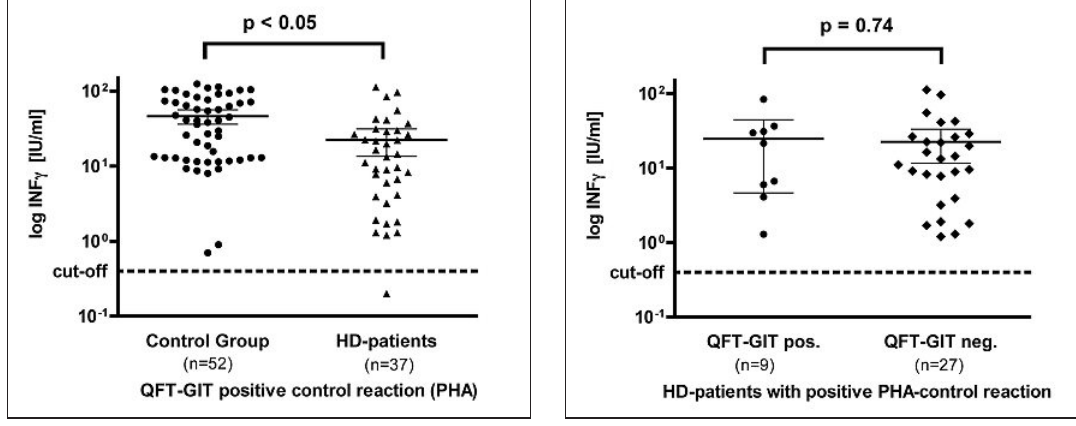
Figure 2 A & B Comparison of INF- g secretion upon mitogenic stimulation (A) in healthy controls (n = 52) vs HD-patients (n = 37), and (B) comparison within the HD-group in non-anergic patients who tested QFT-GIT negative (n = 26) or QFT-GIT positive (n = 10).The median INF- g titre in the control group versus the HD-patient group was 46.2 IU/ml versus 22.4 IU/ml (p <0.05). The median INF- g secretion of the control reaction in HD-patients tested QFT-GIT positive or negative was 24.6 and 22.5 IU/ml, respectively (p = 0.57). INF- g = interferon g ; PHA = phythohaemagglutinine; HD = haemodialysis; QFT-GIT = QuantiFERON Gold InTube